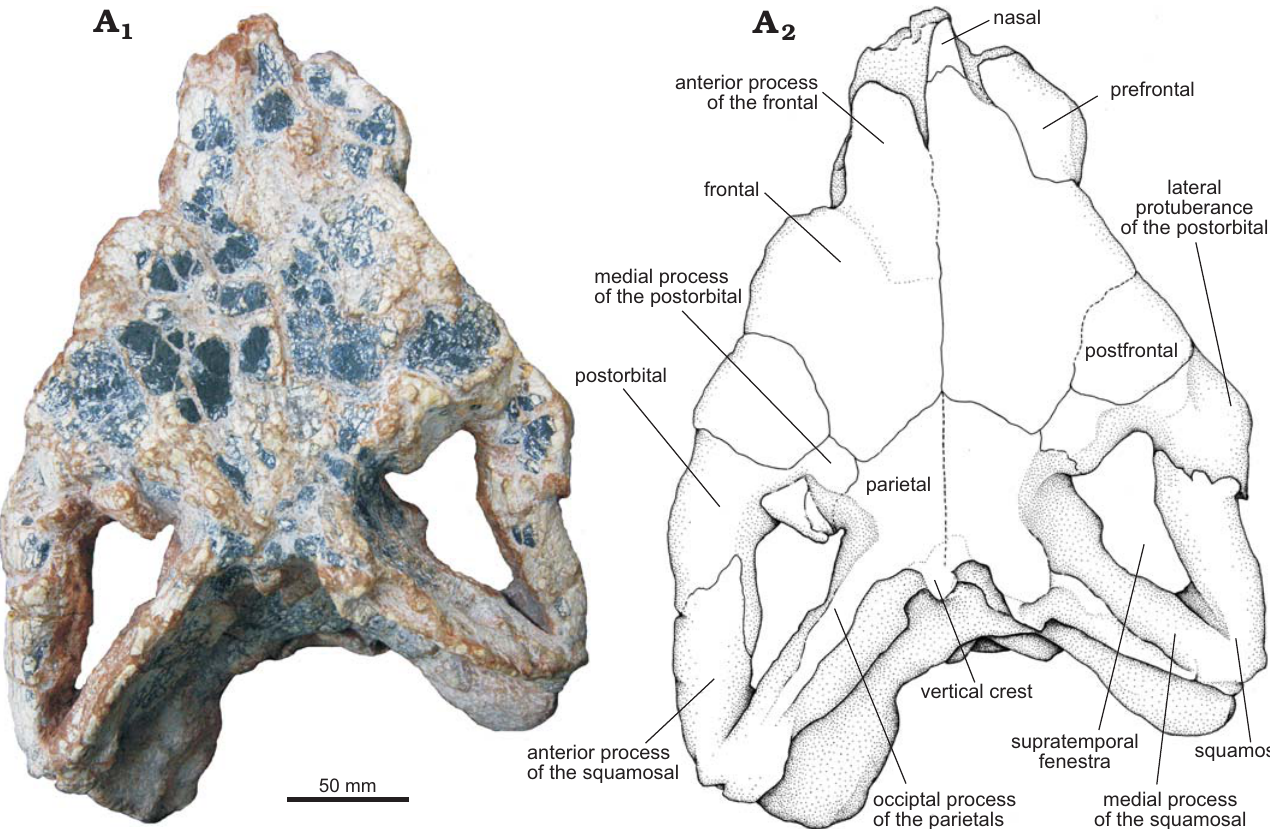
Fig. 11. The pseudosuchian archosaur Prestosuchus chiniquensis Huene, 1938 (UFRGS-PV-0629-T) from the Dinodontosaurus Assemblage Zone, Ladinian, Middle Triassic, Dona Francisca municipality, Rio Grande do Sul State, Brazil; posterior portion of the skull in dorsal view. Photograph (A 1 ) and explanatory drawing (A 2